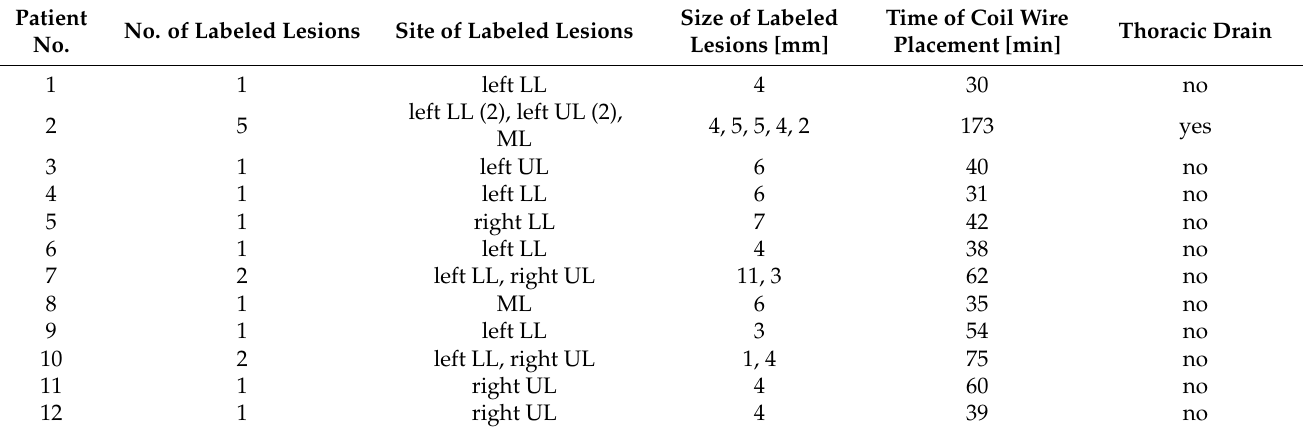
Table 2. Data of CT-guided coil wire placement.